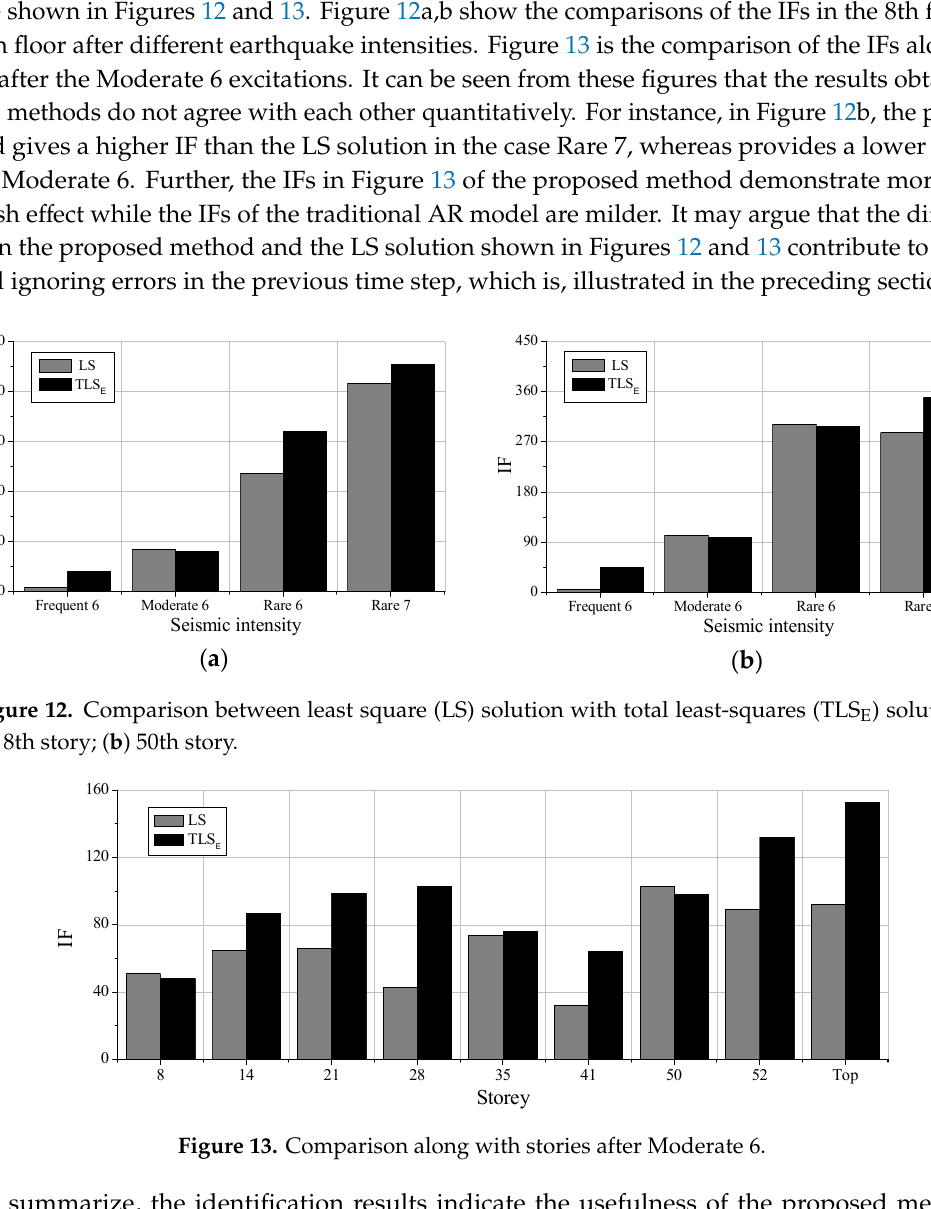
Figure 11. Identification factors (Ifs) along with stories: ( a ) Frequent 6; ( b ) Rare 7.